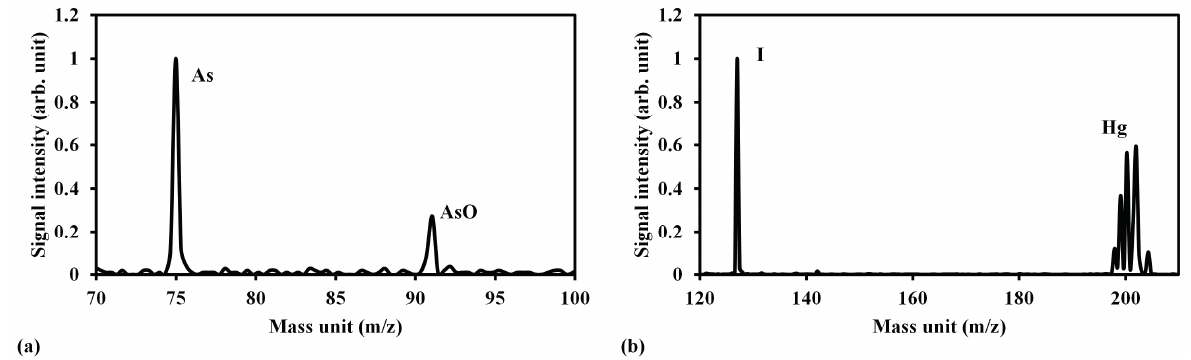
Figure 7. LB-TOFMS mass spectra of Hg, CH 3 I and As in N 2 using 532 nm laser irradiation. ( a ) Arsenic measurement result. Conditions: buffer gas N 2 , pressure 0.5 Pa, power 100 mJ/p, lens angle α 0°; ( b ) Mercury and iodine measurement result. Conditions: buffer gas N 2 , pressure 0.15 Pa, power 100 mJ/p, lens angle α 10°, mercury concentration 3.2 ppm, iodine concentration 4.8 ppm. The signal was normalized by the maximum signal intensity in each measurement